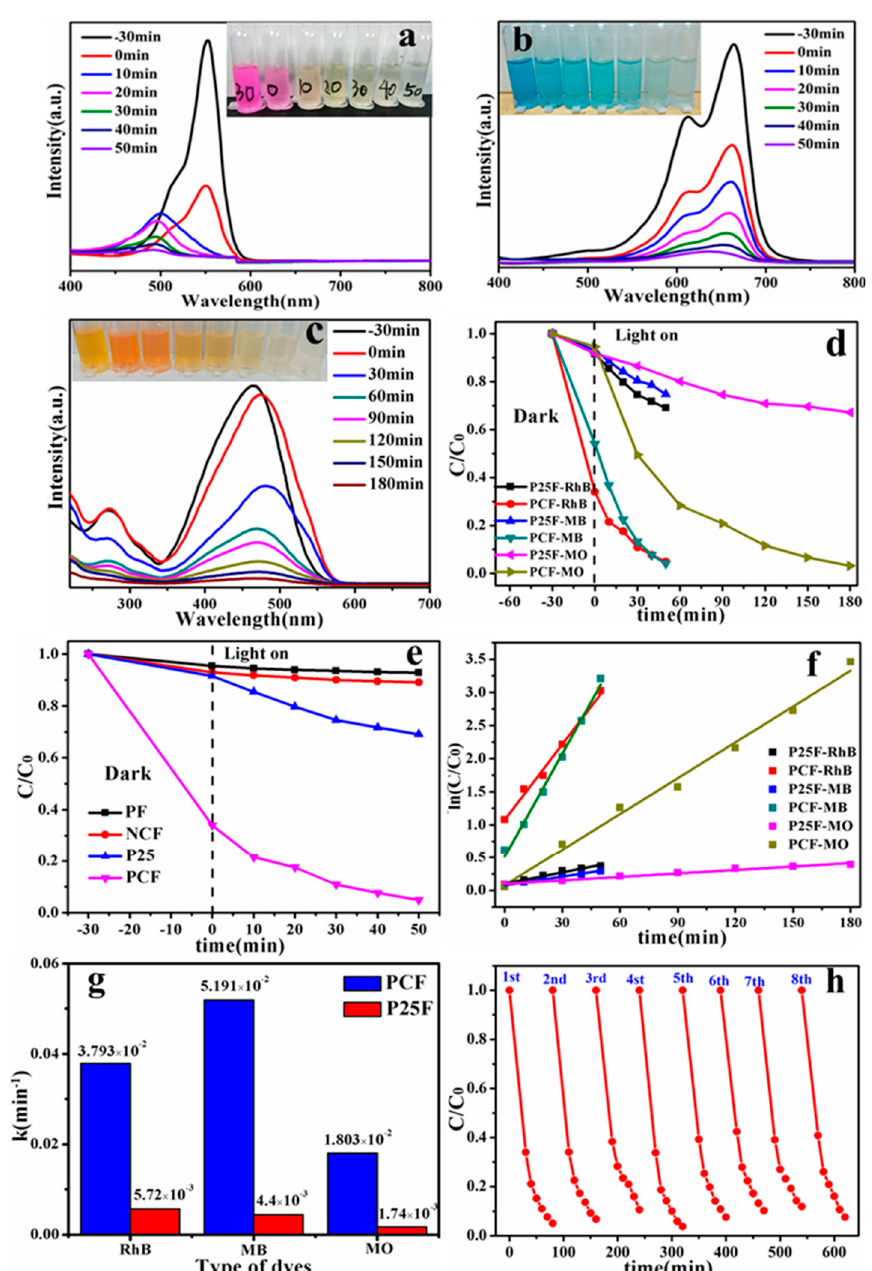
Figure 9. UV-vis absorption spectra over time during the degradation of RhB ( a ), MB ( b ), and MO ( c ) by photocatalyst-coated fabric. ( d ) Photodegradation of three dyes by photocatalyst-coated fabric. ( e ) Degradation of RhB by pure fabric, neoprene-coated fabric, P25, and photocatalyst-coated fabric. ( f ) Pseudo first-order kinetic curve and ( g ) kinetic constants for photodegradation of three dyes using photocatalyst-coated fabric and P25, ( h ) recycling of photocatalyst-coated fabric for the photodegradation of RhB.